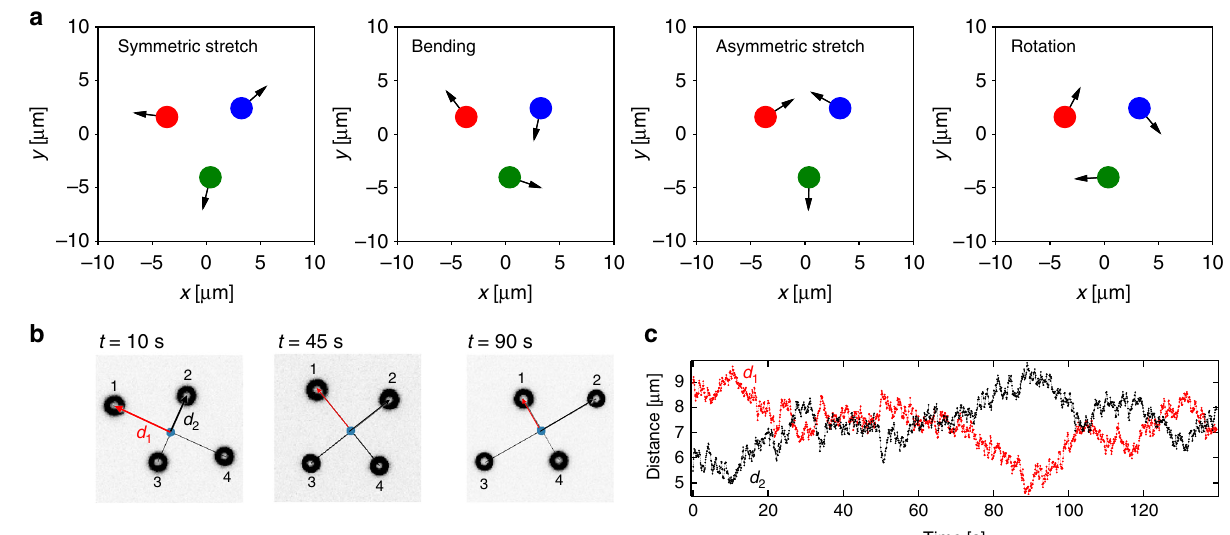
Fig. 5 Principle components of the trimer and isomerization of the tetramer. a The principle components of the trimer as calculated from a principle component analysis (PCA) of the particle displacements in the center of mass coordinate system. Depicted are the symmetric stretch, bending motion, asymmetric stretch, and the rotation sorted by the magnitude of the eigenvalue found in the PCA. b Isomerization of the tetramer. The images represent the observed dark- fi eld images of the 4 active particles at three different times ( t = 10 s, t = 45 s, t = 90 s). Particles have been labeled to keep track of their position. c Timetrace of the distance d 1 of particle 1 and d 2 of particle 2 from the center of mass indicating the isomerization. The distances d 1 and d 2 exchange in size after a time period of about 75 s. The isomerization is driven by Brownian